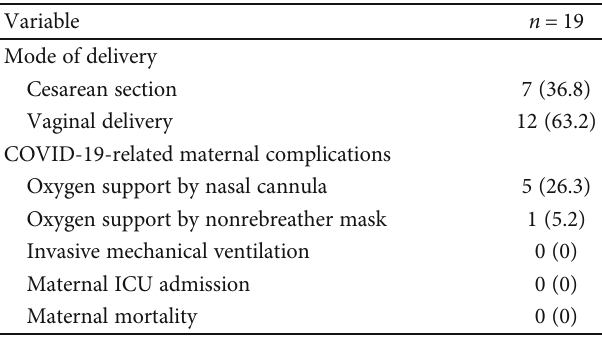
Table 2: Pregnancy outcomes.